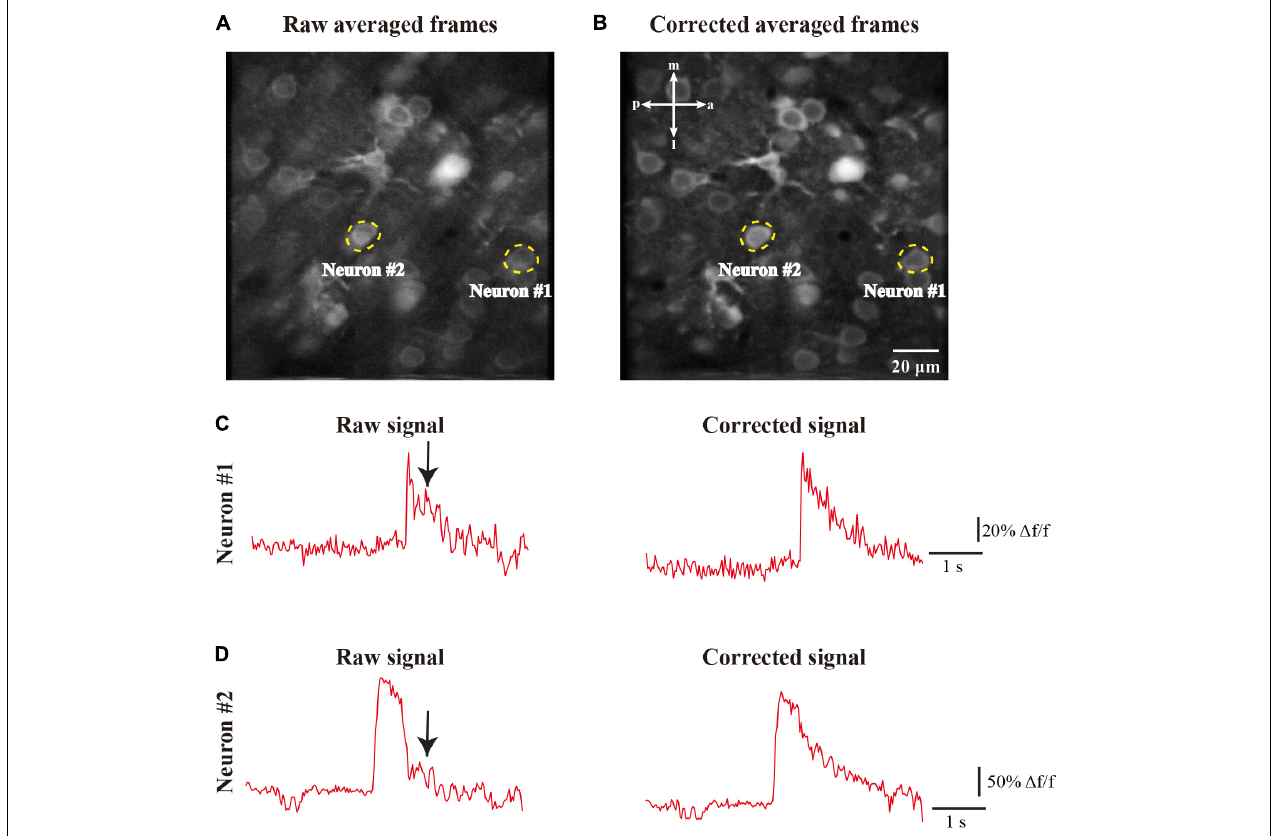
FIGURE 12 | The motion correction effect of the neuronal signals. (A) Two representative neurons in the raw averaged frames, the neurons are indicated by dashed circles in yellow. (B) Two representative neurons in the corrected averaged frames. (C) The raw and corrected Ca 2 + signals of neuron #1. (D) The raw and corrected Ca 2 + signals of neuron #2. The black arrows indicate the distorted period due to motion